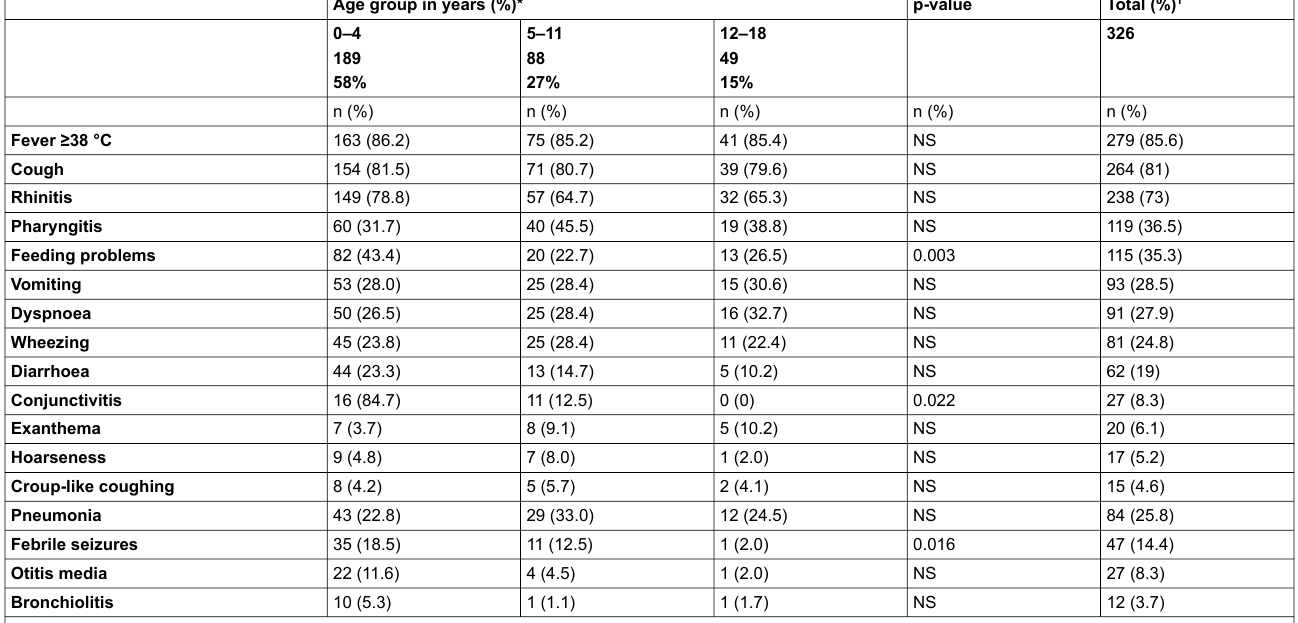
Table 3: Signs and symptoms before or during hospital stay in 326 children with laboratory-proven influenza A/H1N1/09 virus infection, by age group. Age group in years